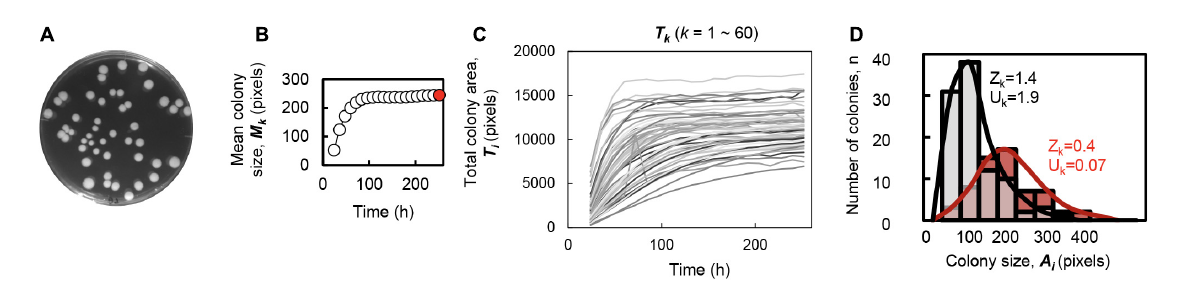
FIGURE1 Parameters used for the colony spatial analyses. (A) Image of colonies on the agar plate. (B) Temporal changes in the averaged size of the colonies formed on a single plate. The steady state is indicated in red at the time point of 252 h, which is corresponded to the image shown in panel (A) . (C) Temporal changes in the total area of all colonies formed on a single plate. The gradation in gray indicates a total of 60 colonies located on the identical plate. (D) Histogram of the colony size within a single plate. As representative examples, both the histograms and the fitted distributions of the areas of the colonies grown on the plates are shown. Color variation (gray and red) represents two different plates. The calculated values of skewness ( Z k ) and kurtosis ( U k ) of the distributions are indicated.